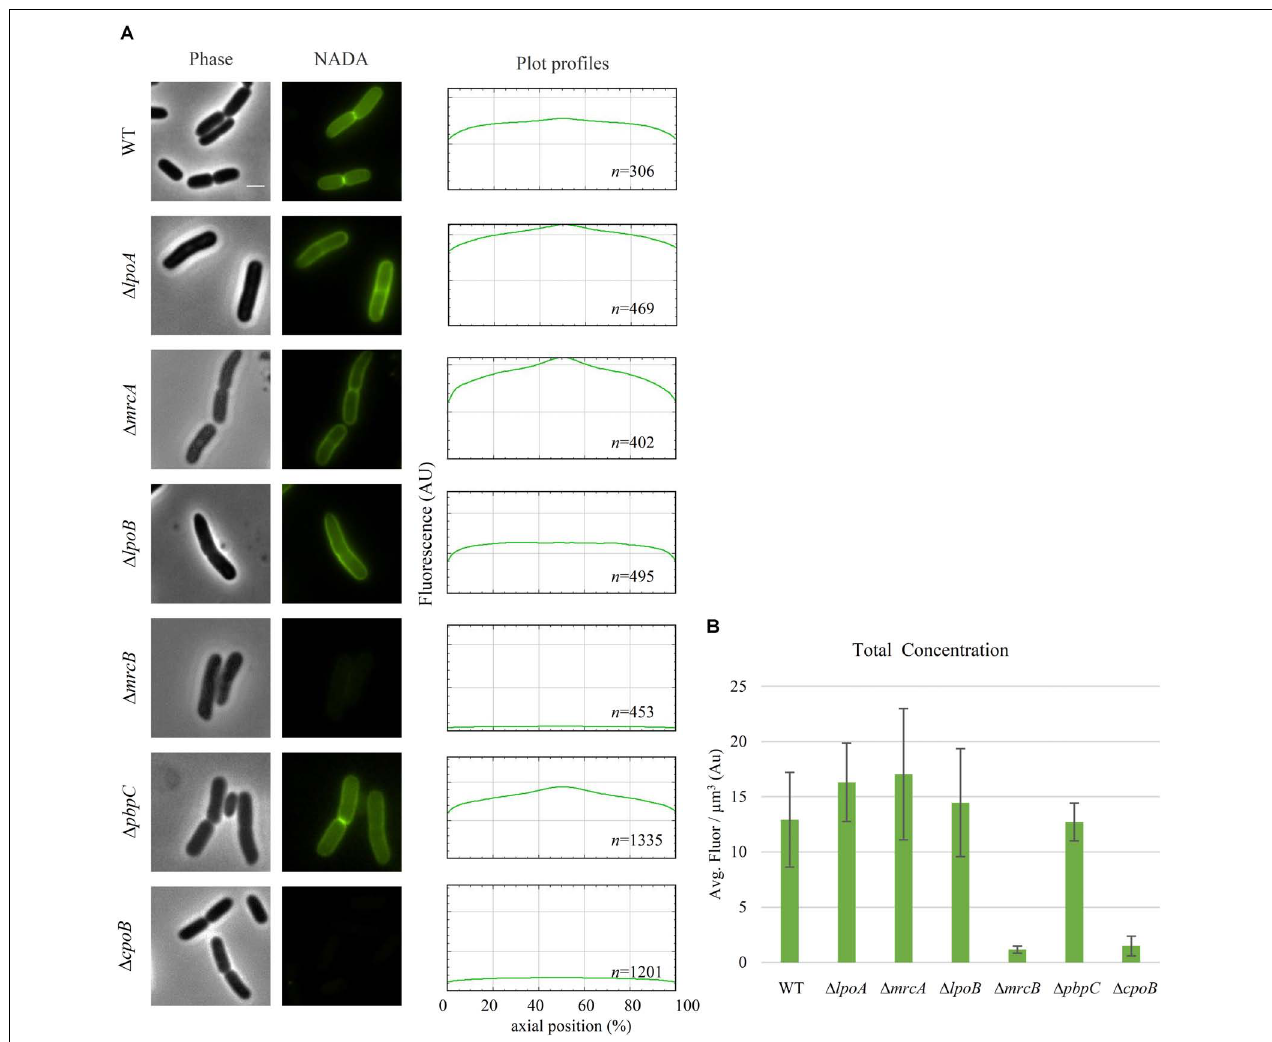
FIGURE 4 | PBP1b is required for NADA incorporation by LdtD. (A) Phase contrast and corresponding fluorescence images of cells of BW25113, BW25113 (cid:49) lpoA , BW25113 (cid:49) mrcA (encoding PBP1a), BW25113 (cid:49) lpoB , BW25113 (cid:49) mrcB (PBP1b), BW25113 (cid:49) pbpC (PBP1c), and BW25113 (cid:49) cpoB expressing ldtD and labeled with 0.5 mM NADA. Scale bar, 2 µ m. The right panel shows the fluorescence profiles per average cell (from 0 to 1000 AU) plotted against normalized cell length (from 0 to 100%). n represents the number of cells analyzed. (B) Concentration of NADA fluorescence (fluorescence signal per µ m 3 average cell